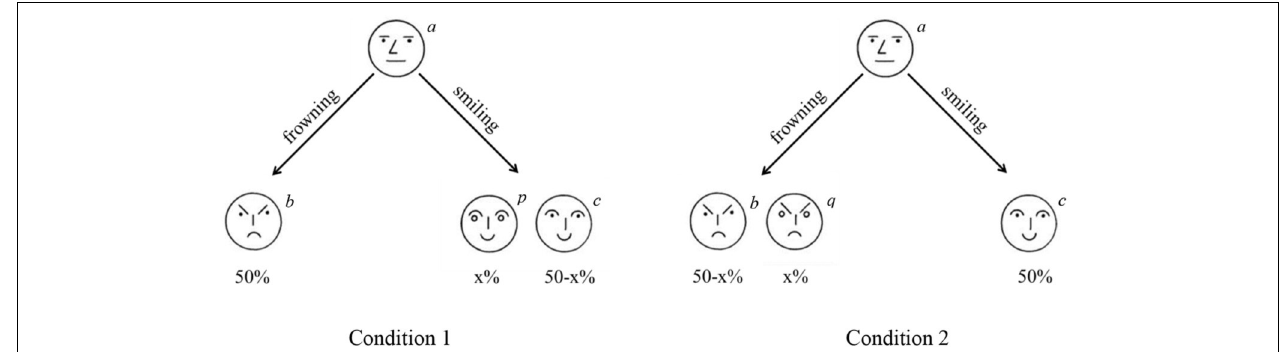
FIGURE 3 | Illustration of substitution effect. In the situation below more people would choose the face on the left ( b ) in condition 1 as compared to condition 2 because choices for a frowning face are spread over two options in condition 2.